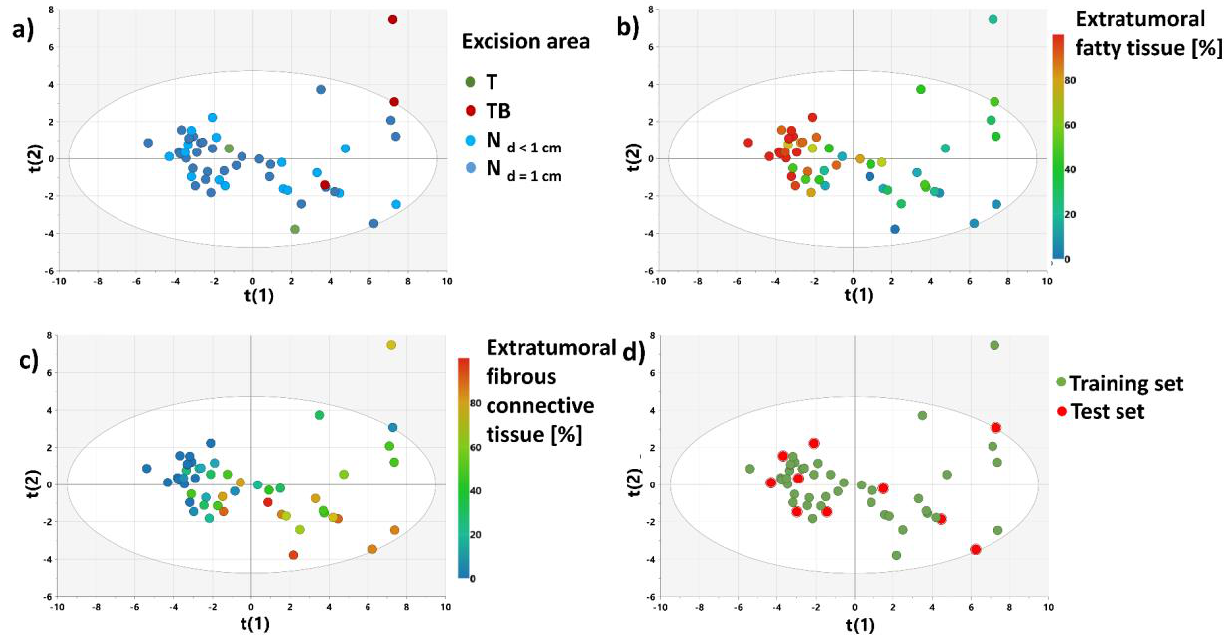
Figure 5. The scores plot obtained from the PCA model 3 colored according to: a sample excision area ( a ), the contents of fatty tissue ( b ) and connective tissue ( c ); a sample splitting into the test and training sets used for the OPLS-DA 2 model development and evaluation ( d ). The scores for the i-th principal component are denoted as t(i).